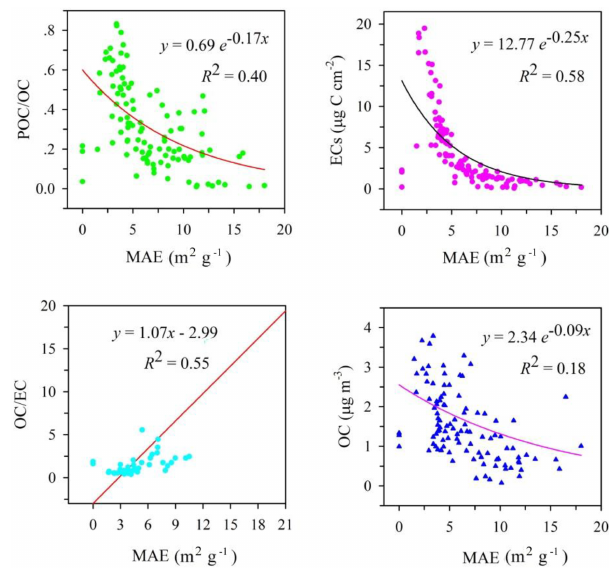
Figure 9. Regression analysis for scatter plot between EC MAE and POC / OC and OC / EC ratios, and between MAE and EC s and OC concentrations for aerosols sampled at Mt. Yulong.